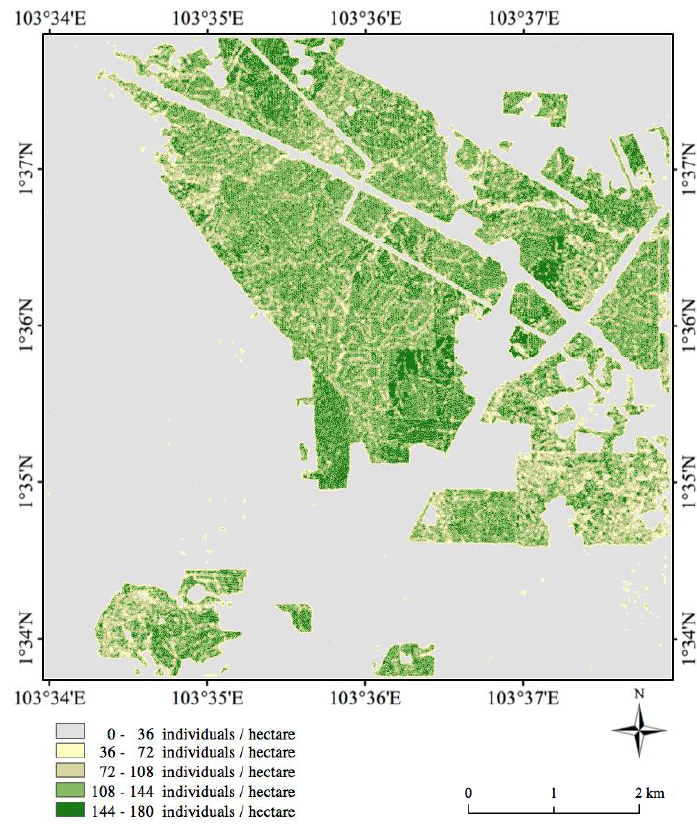
Figure 7. The density map of detected oil palms in our study area.